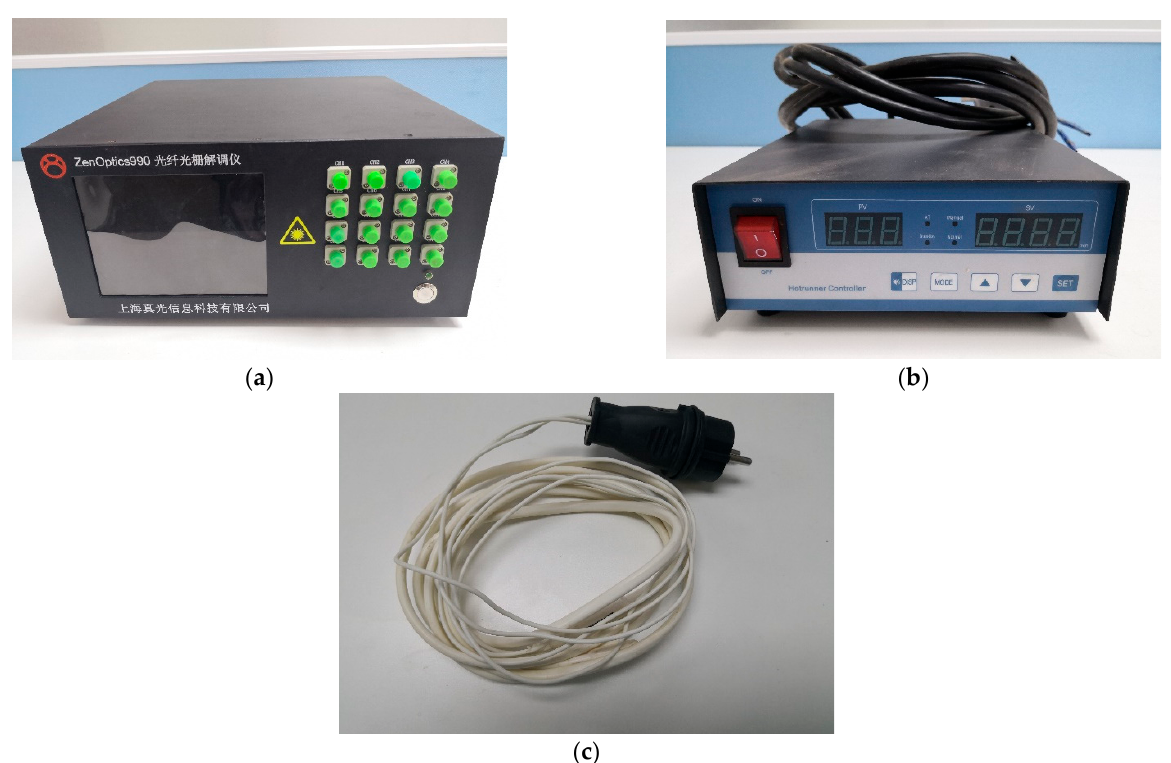
Figure 8. Equipment used in this work: ( a ) the FBG demodulator; ( b ) the thermostat; ( c ) the heating belt.